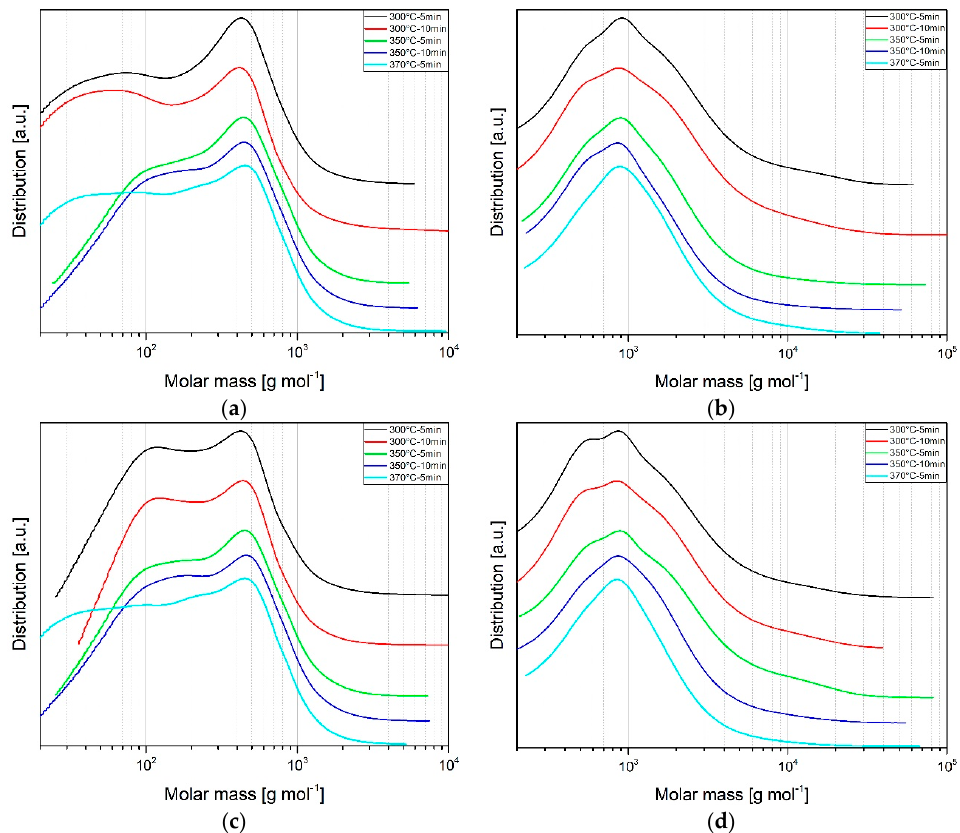
Figure 14. Stacked molecular weight distribution of BC1 (left) and BC2 (right) from experiments carried out at 10% w/w ( a , b ) and 20% w/w ( c , d ).